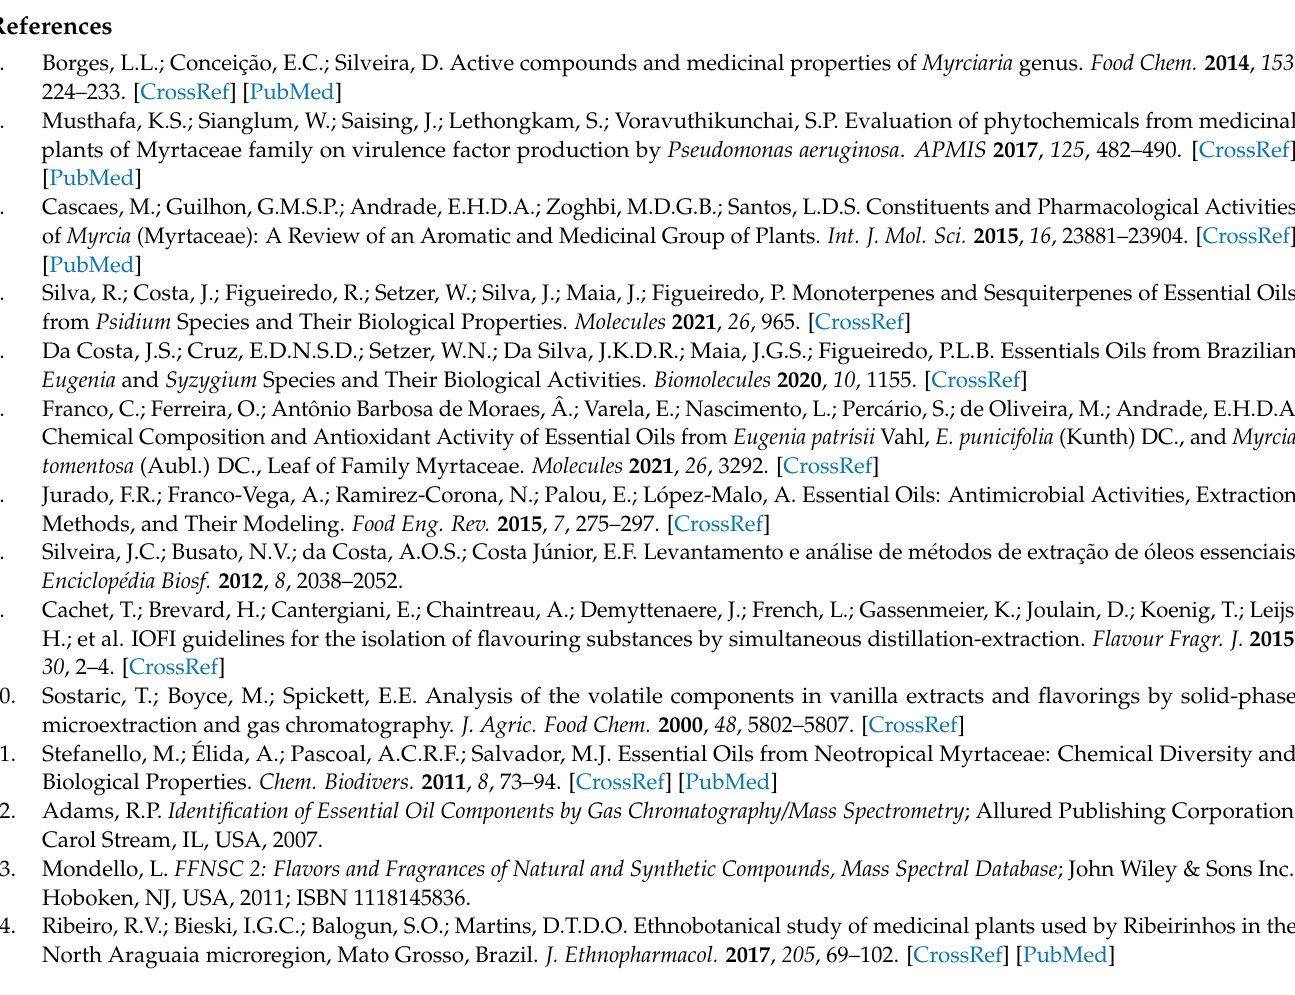
Figure A2. GC chromatograms of collected Myrciaria specimens (Mflo = Myrciaria floribunda , Mdub = Myrciaria dubia , Mten = Myrciaria tenella ).